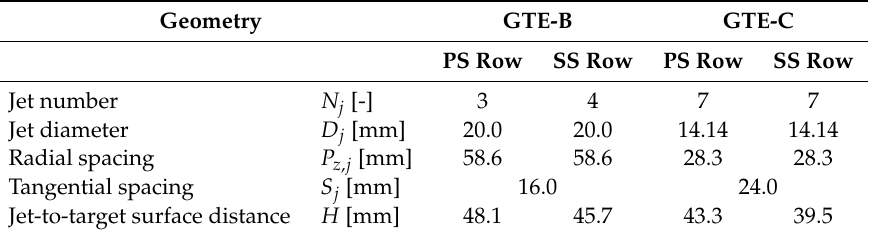
Table 1. Investigated systems geometric